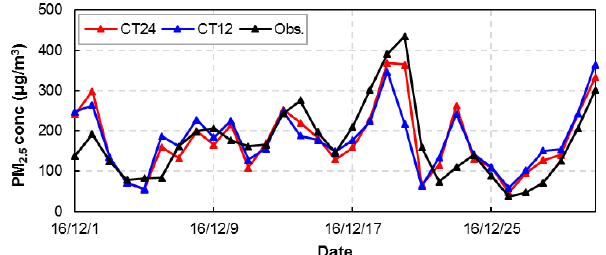
Figure 11. Time series of the daily PM 2 . 5 concentrations for the continuous simulation for Xi’an. The black line represents obser- vations, and the blue and red lines show simulated data starting on 26 November at 00:00UTC and on 26 November at 12:00UTC re-